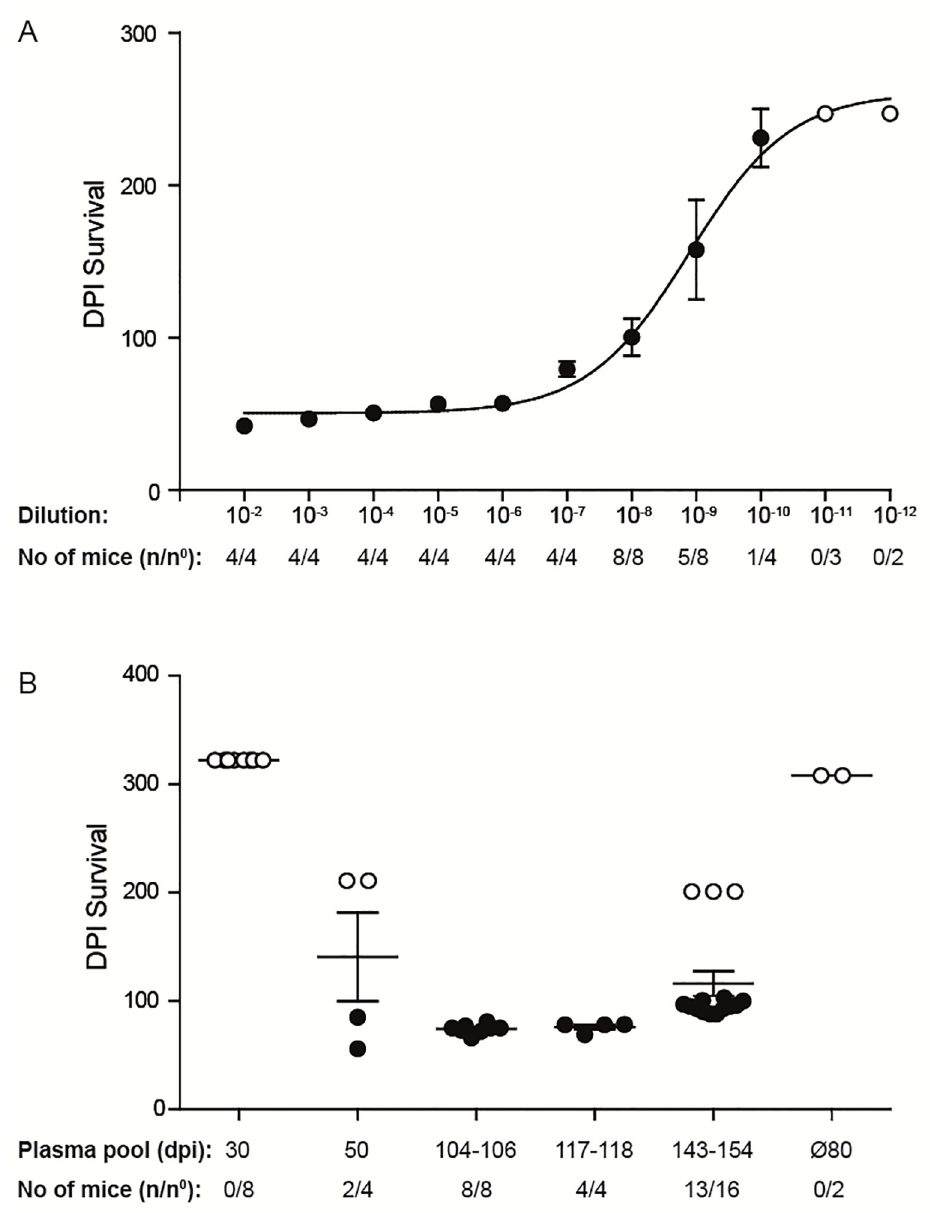
Fig 2. Survival plots of tg (SHaPrP) mice. (A) For titer determination, tg (SHaPrP) mice were inoculated with serial 10-fold dilutions of a 10% (wt/vol) 263K hamster brain homogenate ranging from 10 − 2 to 10 − 12 . (B) Bioassay of Tg (SHaPrP) mice that were inoculated i.c. with PSR1 beads incubated with pooled plasma samples from hamsters infected with 263K prions. Individual pools of plasma samples from pre-symptomatic hamsters harvested at 30 (n = 20) and 50 dpi (n = 20) and from symptomatic hamsters harvested at 104–106 dpi (n = 14), 117–118 dpi (n = 15), and 143 and 154 dpi (n = 11) were used. Data points: mean incubation times ± standard error of the mean. Mice that did not develop a prion disease until the end of the experiment are indicated by open circles. n/n˚: indicates the attack rate (number of mice developing a prion disease divided by the total number of inoculated mice). Ø 80: indicates the control group of mice inoculated with PSR1 beads after incubation with plasma from healthy 80 days old hamsters (n = 2).